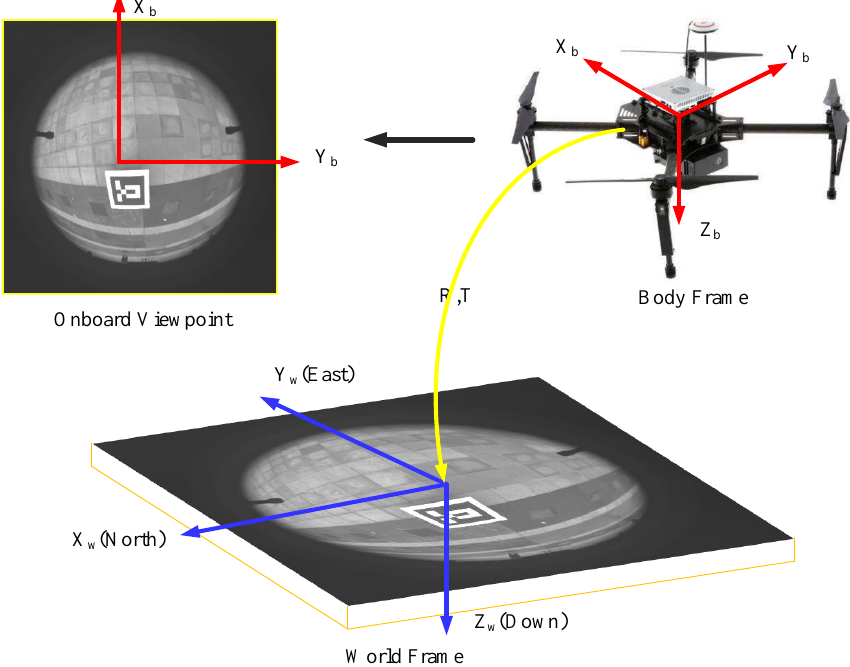
Figure 6. The transformation between the World Frame ( X w , Y w , Z w ) and the Body Frame ( X b , Y b , Z b ) . In this system, the world frame is North East Down